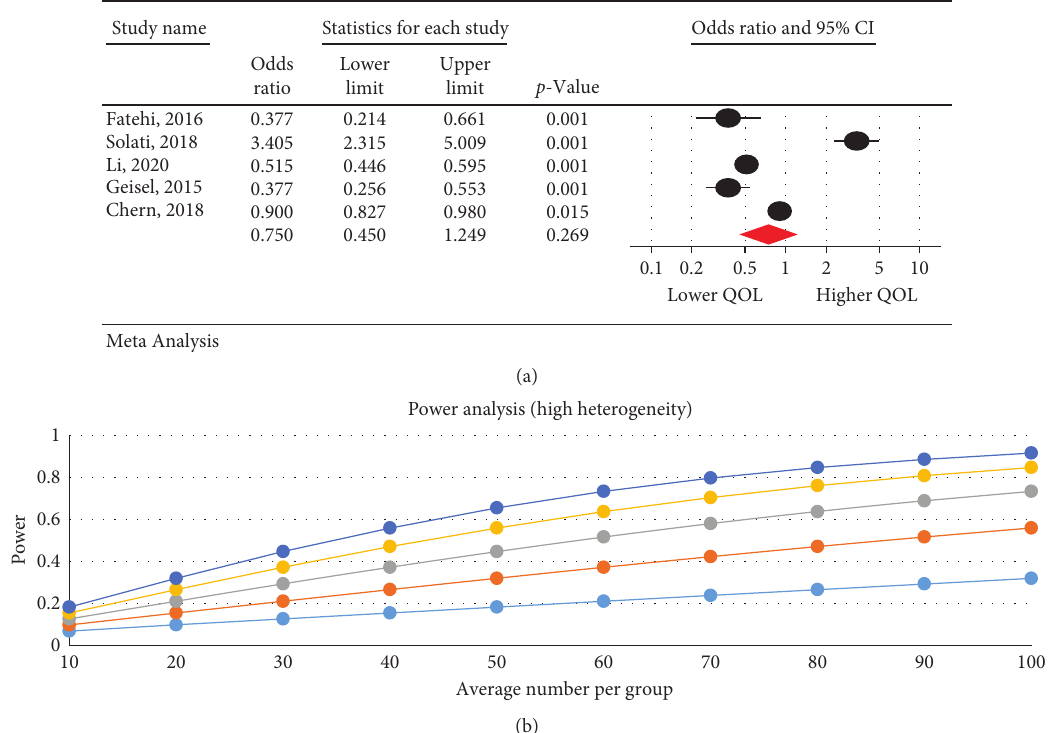
Figure 7: The relationship between the severity of internet addiction and the quality of life in the social